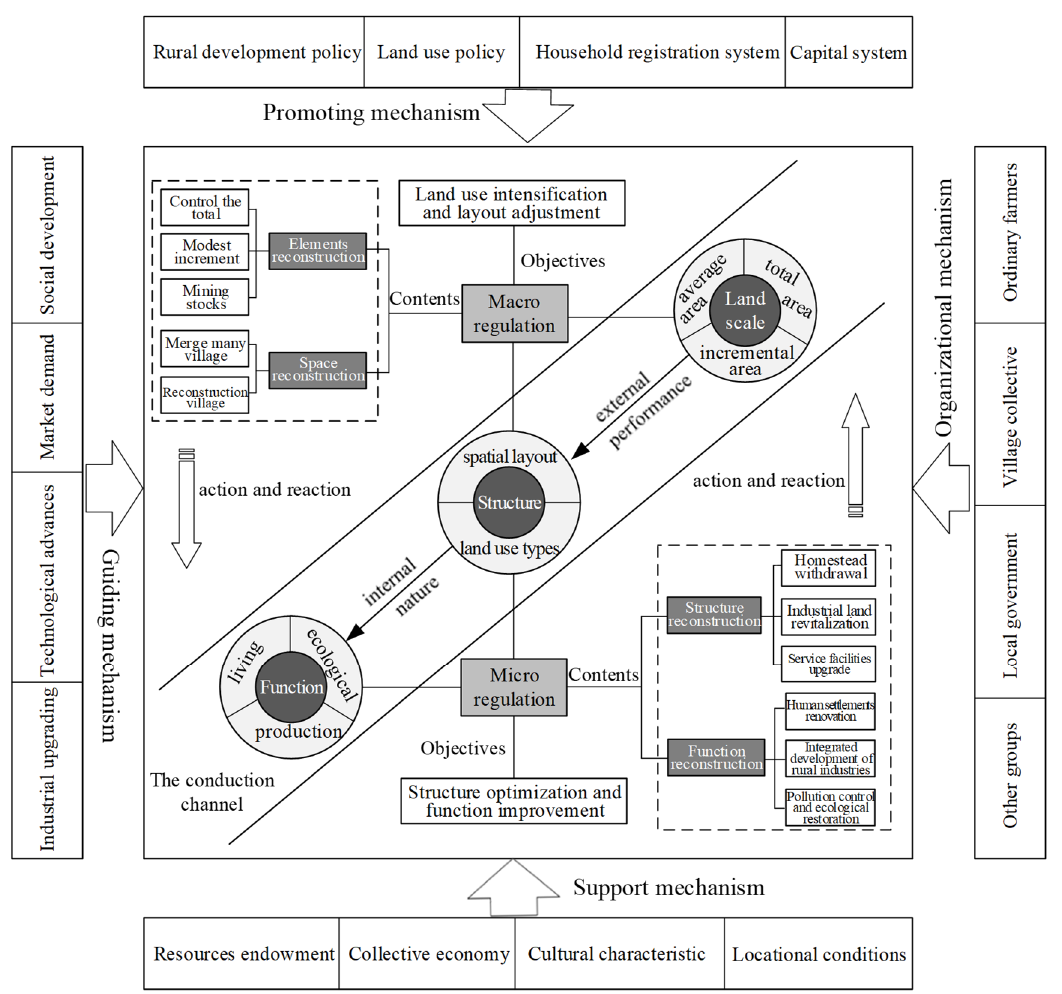
Figure 10. The framework of rural reconstruction based on the integration of “factor, structure, and function”.